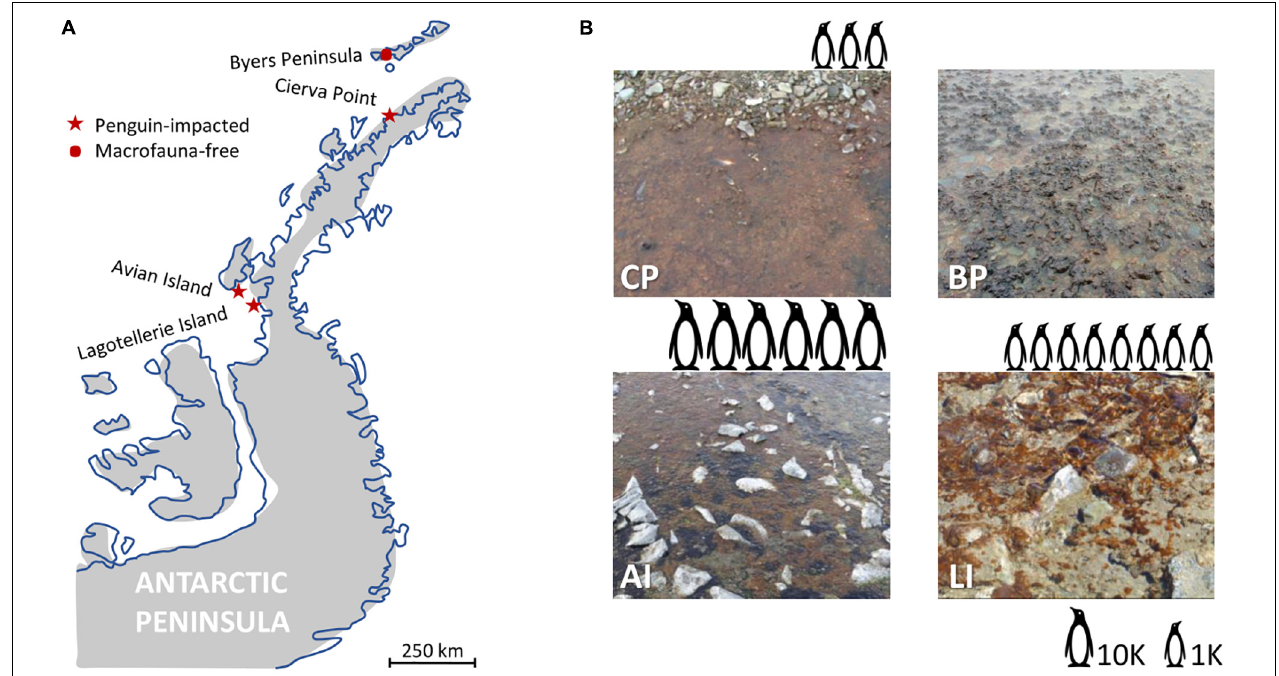
FIGURE 1 | Map indicating the location of the sampling areas along the Antarctic Peninsula. (A) Distribution of the sampled microbial mats along the Antarctic Peninsula. Red stars indicate the sampling areas with penguin colonies in their surroundings, whereas the red dot indicates the sampling area isolated from marine vertebrates. (B) Detailed picture of microbial mats from Byers Peninsula Plateau (BP), Caleta Primavera (CP), Avian Island (AI), and Lagotellerie Island (LI). Images of penguins represent the population (number of nests) of penguin colonies from CP, AI, and LI sampling areas (data from MAPPPD; Humphries et al.,